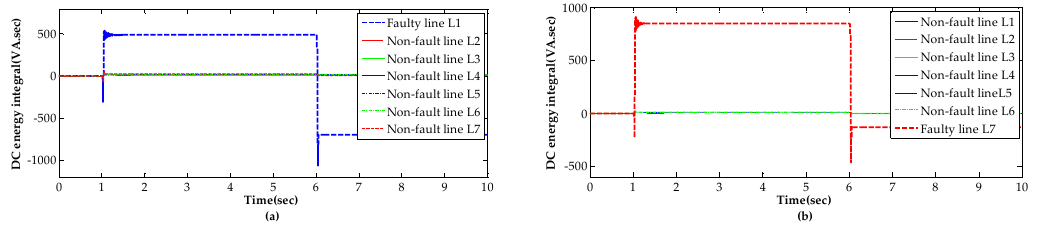
Figure 12 . Results of metal SPG faults occurring on the line L 1 and the line L 7 , the fault location is 2 km away from the bus, the fault time is 1.025 s, and the shunt resistance is put into at 6.025 s. ( a ) The results of the shorter line L 1 ; ( b )The results of the longer line L 7 .